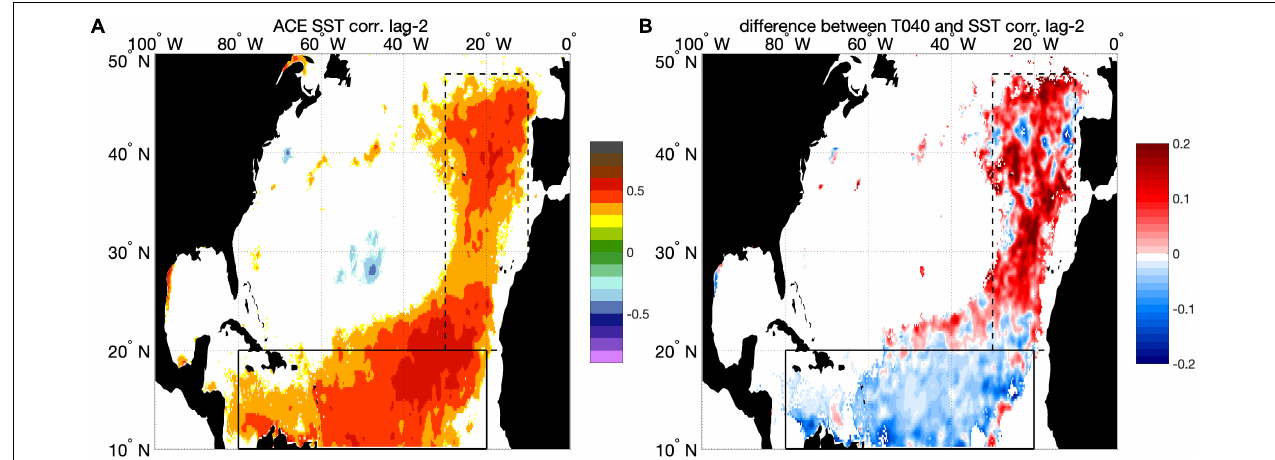
FIGURE 4 | The role of sub-surface ocean temperature in modulating Atlantic Tropical Cyclones (TC): correlations between September Accumulated Cyclone Energy over the Atlantic Ocean and July ocean temperature. (A) High correlations (red pattern) appear not only over the TC main development region (solid black box), but also over the remote region (dotted black box). In fact, ocean temperature also affects Atlantic TC genesis through the modulation of trade winds: a high temperature over the Eastern Atlantic (dotted black box) induces a lower wind shear in the TC genesis region, thus more pronounced TC activity. (B) Considering the subsurface ocean temperature (0–40 m, -T040), instead of the only surface temperature [ (B) shows difference between T040 and SST correlations with ACE] as a TC activity predictor, improves our ability to forecast Tropical Cyclones on a seasonal time scale (red pattern). In particular, high quality measurement of June–August ocean temperatures is fundamental for the prediction of September TC activity (Scoccimarro et al.,